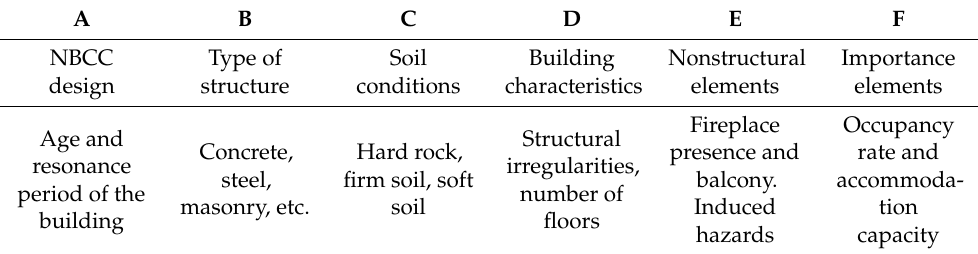
Table 1. Criteria used to determine the building seismic vulnerability (adapted from NRC1992, NBCC2005, and FEMA- 154).